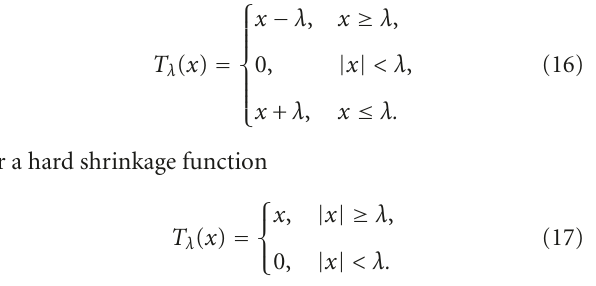
Let μ = ( j , l , k ) be the collection of the triple